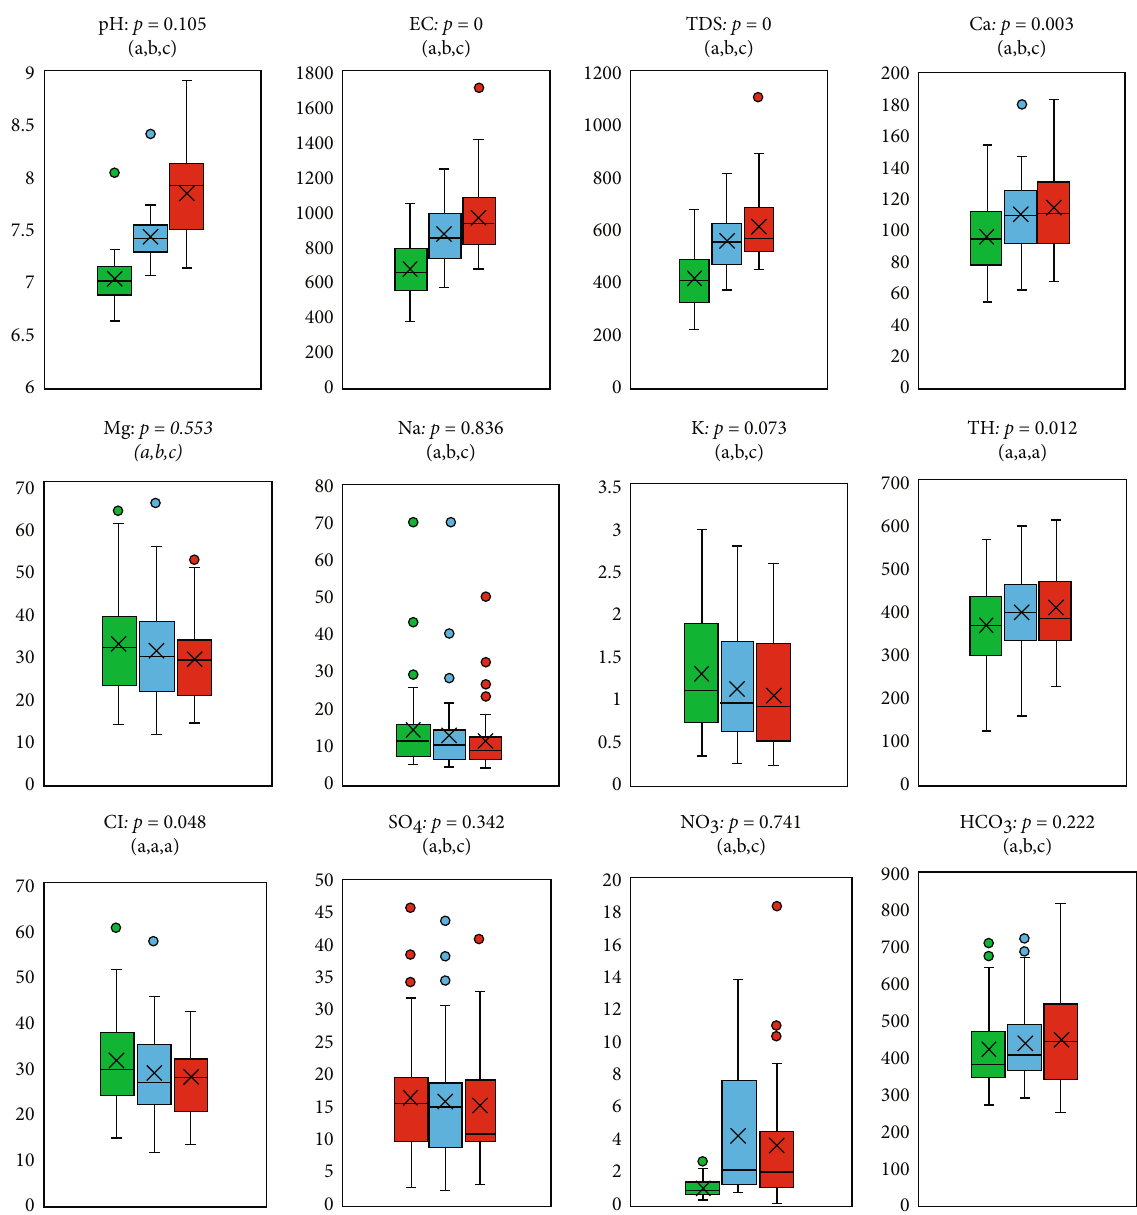
Figure 3: Boxplot illustrations of the upper and lower quartiles (box); median (black line within the box); 1 : 5 × interquartilerange (IQR) (cross mark in the box); and outliers (circles) for designated variables in the two sampling seasons PRM (green) and POM (red). As stated by Mann – Whitney U -test, letters “ a ” and “ b ” in each panel signify suggestively di ff erent data deliveries at p < 0 : 05 (in